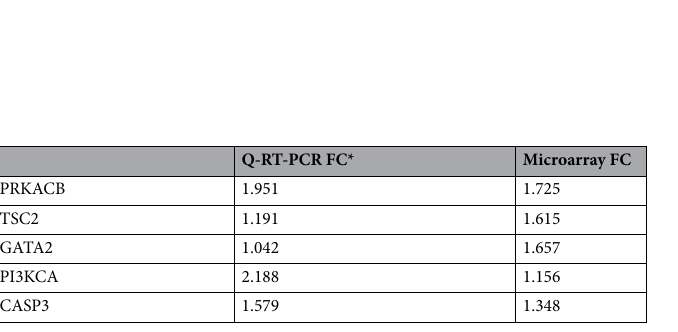
Table 6. Fold chance values of RT-PCR and microarray data. Q-RT-PCR quantitative real time polymerase chain reaction, FC fold change. *Note that FC was assessed by the 2 −ΔΔCt method for